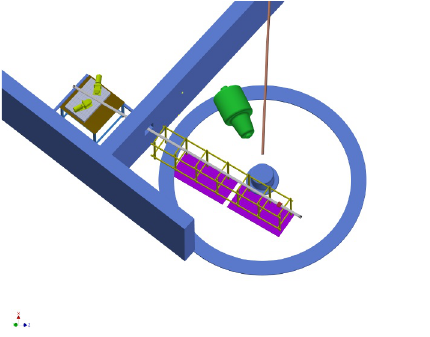
Figure 2. A schematic of the 10 m RABITTS. The track extends from the counting station with two HPGe detectors on the left side, through the concrete shielding wall, to the irradiation position on the right